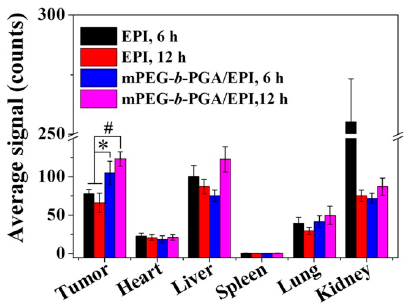
Figure 9. Average signals collected from the tumors and major organs ( i.e. , heart, liver, spleen, lung, and kidney) in H22 HCC-xenografted BALB/c mice at 6 or 12 h after intravenous injection of free EPI or mPEG- b -PGA/EPI. Data were presented as a mean ± SD ( n =3; * p < 0.05, # p < 0.01).